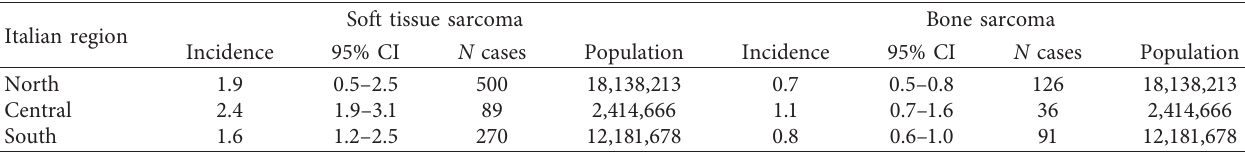
Table 3: Incidence rates (standardised to the age structure of the world population in 2000–2025) of soft tissue and bone sarcoma per 100,000 per year, by Italian